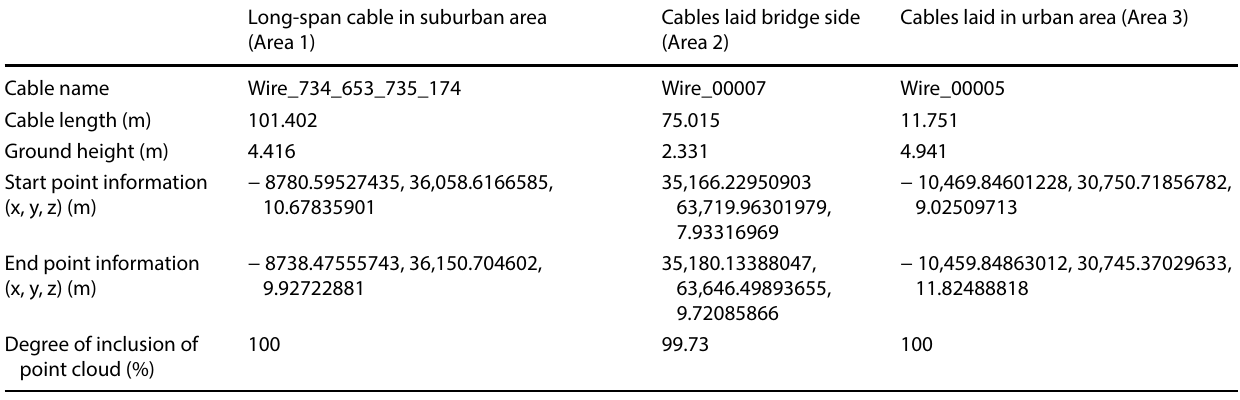
Table 2 Summary of configuration data for 3D cable models